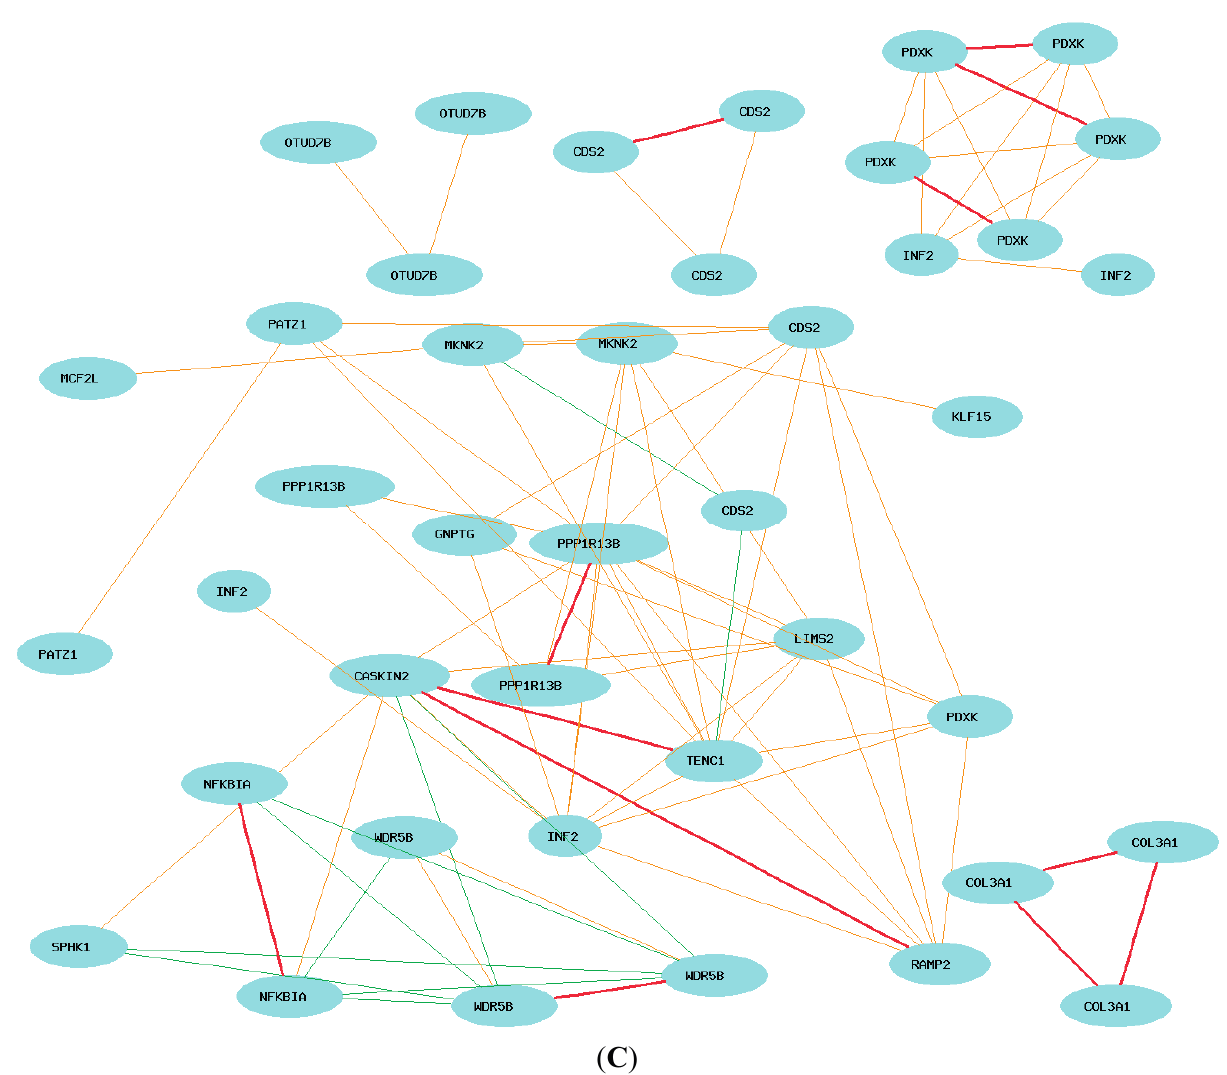
Figure 7. Gene network of top collated genes in mice and humans. Each figure shows Pearson correlation coefficients greater than 0.5 or less than − 0.5. The graph’s canvas is 40.0 by 40.0 cm, and the node labels are drawn with a 14.0 point font, and the edge labels are drawn with a 14.0 point font. ( A ) Correlation between COL3A1 and 104 probes of top 44 genes in mice in human lung. The 107 nodes in the graph below show the selected traits. Only nodes with edges are displayed. The 517 edges between the nodes were filtered from the 5671 total edges and drawn as lines; ( B ) Gene network between COL3A1 and 22 unregulated genes selected from mice in human lung tissues. The 59 nodes in the graph below show the selected traits. Only nodes with edges are displayed. The 386 edges between the nodes were filtered from the 1711 total edges and drawn as lines; ( C ) The gene network between COL3A1 and 21 down-regulated genes selected from mice in human lung tissues. The 51 nodes in the graph below show the selected traits. Only nodes with edges are displayed. The 83 edges between the nodes were filtered from the 1275 total edges and drawn as